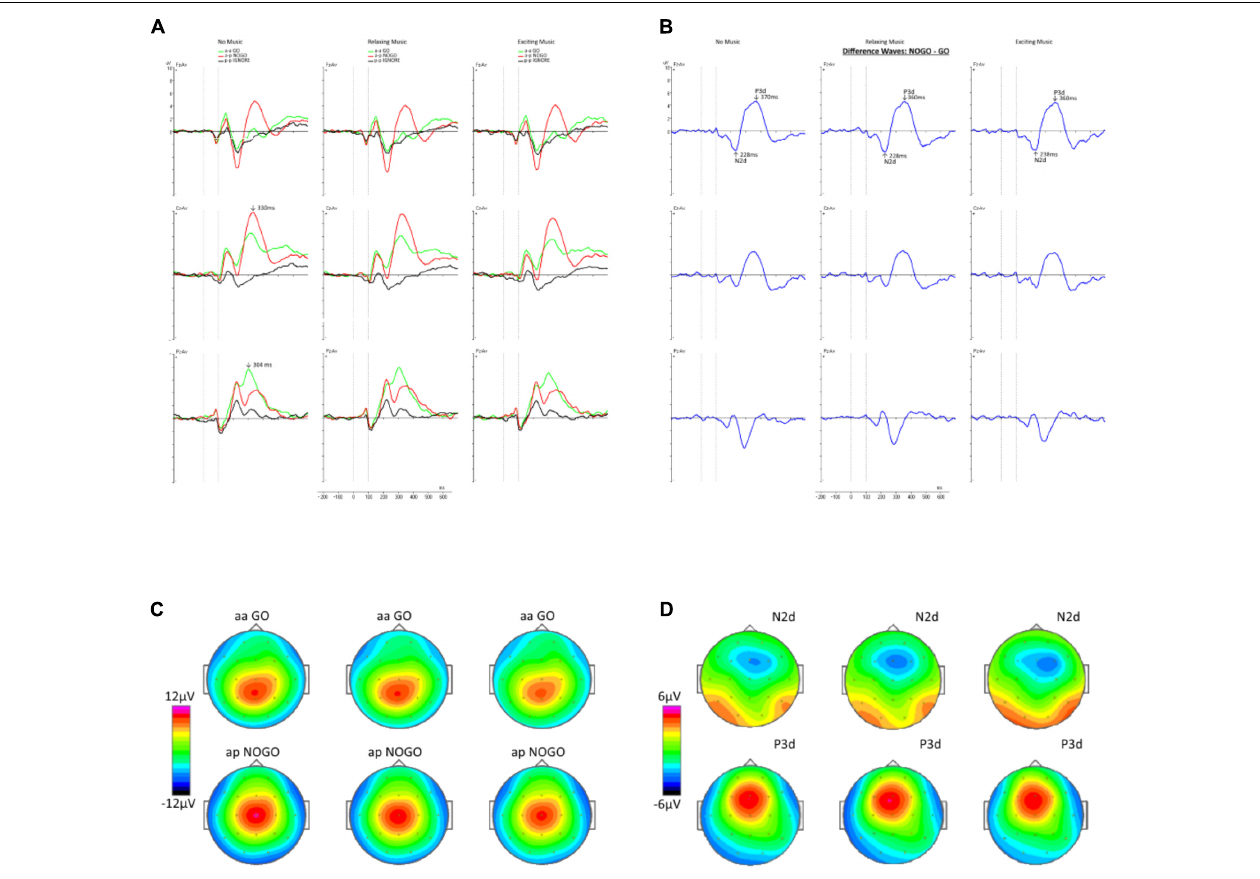
FIGURE 2 | (A) The grand average ERP waveforms in the three conditions are shown for the midline electrodes Fz, Cz, and Pz. The onset of the second stimulus is at time point zero, whereas the second dashed line represents its offset. The green waveforms show the average ERPs for the Go trials, the red ones represent the NoGo trials, and the black curves indicate the Ignore trials. (B) The difference waves corresponding to (A) are depicted for the different conditions. Maximal amplitudes of the N2d and P3d components are indicated by arrows. (C) Topographies in the top row were computed for Go trials and the bottom row represents the NoGo trials. (D) Topographical maps of the N2d (top row) and P3d (bottom row) components.